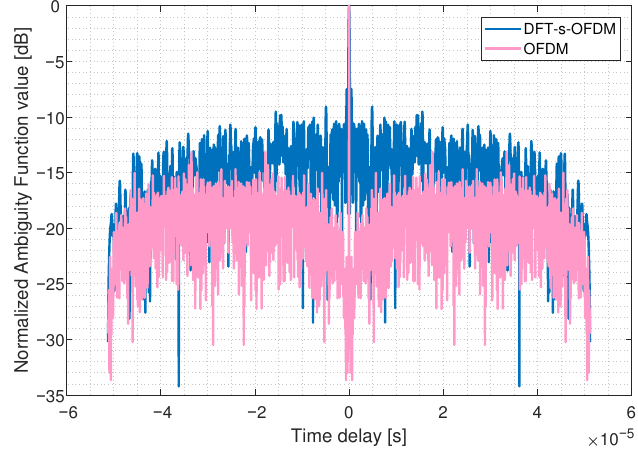
Figure 12. Comparison of ambiguity functions between DFT-s-OFDM and OFDM.